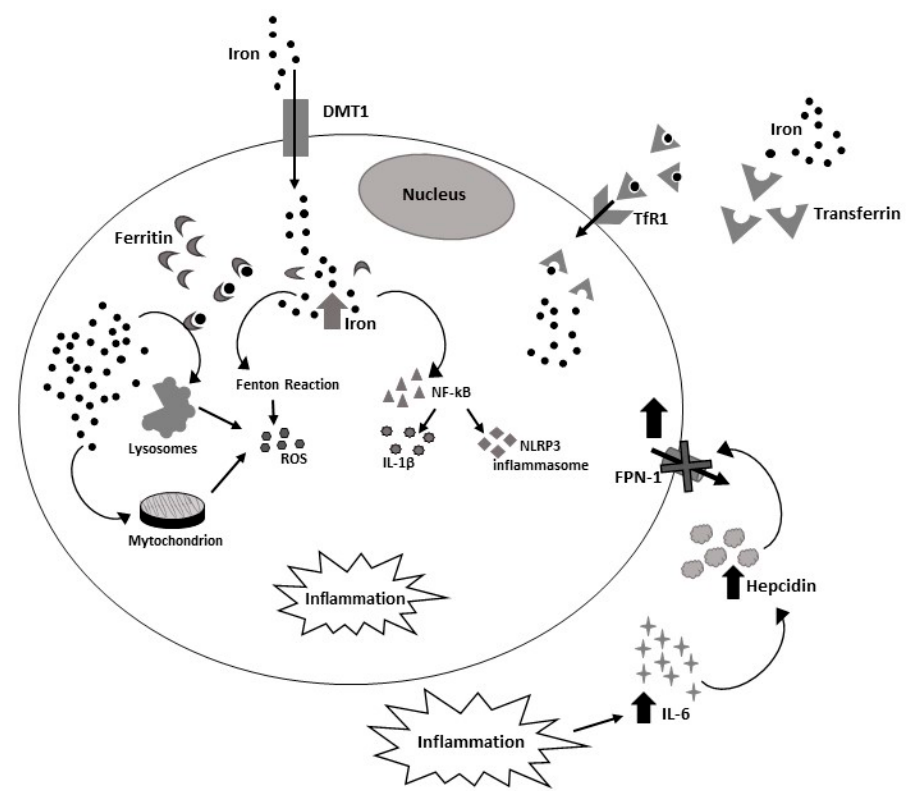
Figure 2. Iron homeostasis alteration in inflammation. During inflammation high levels of interleukin-6 (IL-6) cause an overexpression of Hepcidin responsible for ferroportin (FPN1) degradation and consequently for intracellular iron accumulation. Free iron accumulation is highly toxic for cells, causing reactive oxygen species (ROS) production which causes damage of mitochondria, lysosomes, DNA, proteins and lipids causing senescence, cell death, and inflammation. Oxidative stress increases the level of pro-inflammatory cytokines and also upregulates nuclear factor-kappa B (NF- κ B) leading to an increase of the inflammatory state responsible for the onset of several chronic diseases. IBD chronic inflammation is also responsible for the onset of osteoporosis (OP) in these patients. In particular, high levels of pro-inflammatory cytokines in CD and